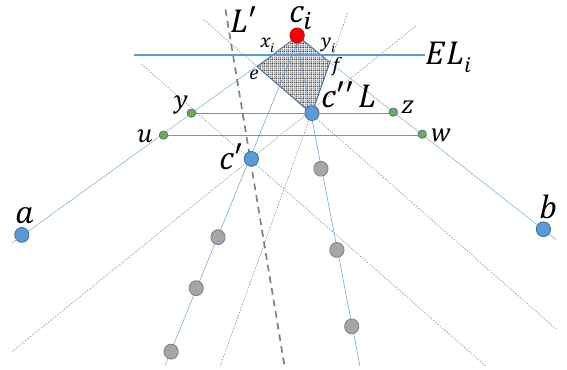
Figure 3. Eligible area computation; the shaded area depicts EA ( c i )